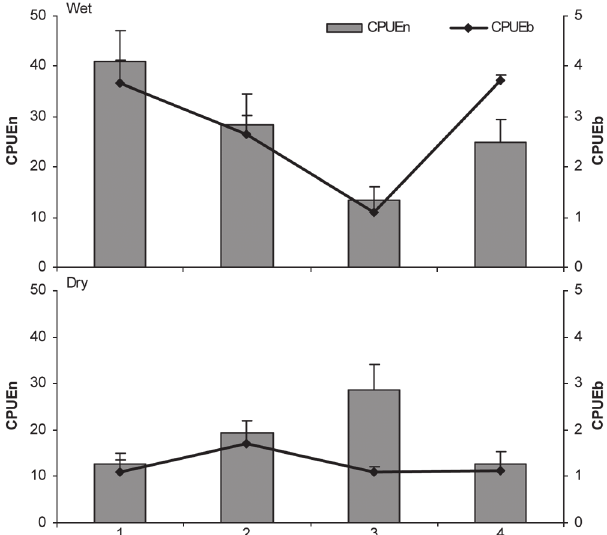
Fig. 3. Spatial variation in species number and biomass by zone (1, 2, 3, 4) in Paraíba do Sul River and Funil